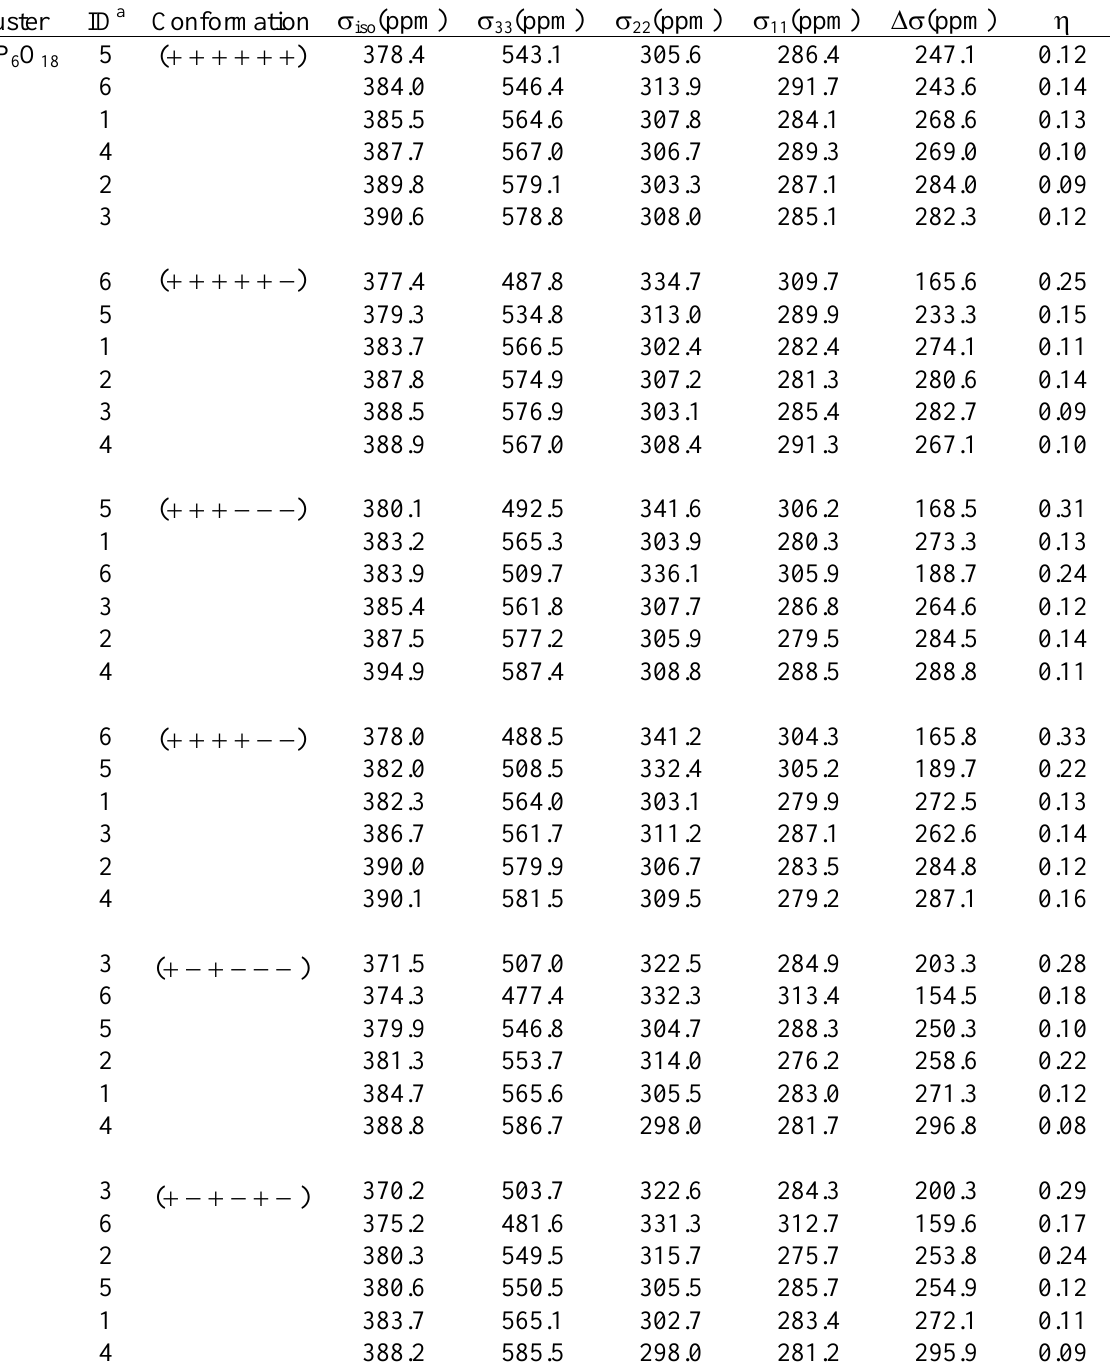
Table 4. Ab Initio NMR CSA Tensors for Cyclic 6-P Membered Phosphate Clusters.